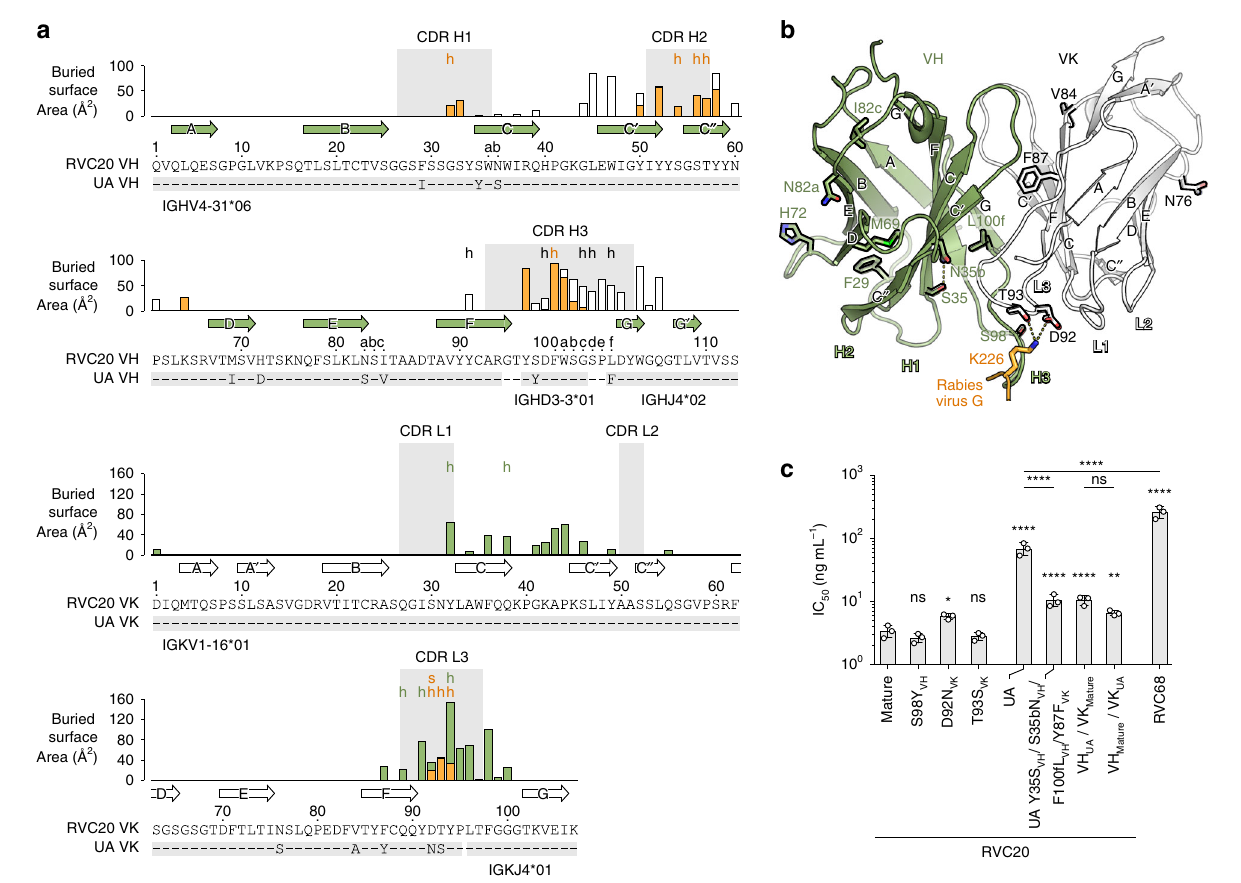
Fig. 2 RVC20 sequence analysis. a Annotation of the RVC20 variable heavy (VH) and variable kappa light (VK) sequences using the Kabat numbering 32 . Differences to the most closely matching germline sequences as determined by IGMT/V-QUEST 27 are indicated below each sequence, de fi ning the inferred unmutated ancestor (UA) sequences. Arrows denote β strands. The color-coded bar chart indicates the BSA per residue in contacts with the light chain, the heavy chain, or the antigen in white, green or orange, respectively; h, hydrogen bond involved; s, salt bridge involved. The CDRs (IMGT convention) are highlighted in gray background. b Positions of the inferred SHMs on the structure of the RVC20 scFv. RABV G residue K226 interacting with D92 VK and T93 VK is shown in orange. c Neutralization of RABV with RVC20 variants or with poorly neutralizing RVC68 on BSR cells 48 h after infection; n = 3 independent experiments. Data are displayed as means ± s.d. Statistical analysis was performed using Tukey ’ s test with α = 0.05. **** P < 0.0001; *** P < 0.001; ** P < 0.01; * P < 0.05; ns, not signi fi cant ( P > 0.05). Source data are provided as a Source Data fi le. Methods expression was then induced with 500 µM CuSO 4 . Cell supernatants were harvested Mammalian cell culture . HEK293-T clone 17 cells (ATCC CRL-11268), BHK-21 1 week after induction, concentrated to 50mL on a 10-kDa MWCO PES membrane (Sartorius), pH-adjusted with 0.1M Tris-Cl pH 8.0, cleared from biotin clone 13 cells (ATCC CCL-10) and BSR cells (a BHK-21 clone, kindly provided by with 15µgmL − 1 avidin, cleared from precipitate by centrifugation at 4000× g for Monique Lafon, Institut Pasteur, Paris) were cultured at 37°C, 5% CO 2 , in Dul- 15 min at 8 °C, and were then used for af fi nity puri fi cation on a 5-mL Strep-Tactin becco ’ s minimal essential medium (DMEM) supplemented with 10% fetal calf Super fl ow hc column (iba Life Science). The two proteins were further puri fi ed by serum (FCS). The BSR-T7 cells 19 (kindly provided by Karl-Klaus Conzelmann, gel permeation chromatography on a HiLoad Superdex 200 pg column (GE Max von Pettenkofer Institute and Gene Center, Munich) for reverse genetics were Healthcare) in 20 mM Tris-Cl pH 8.0, 150mM NaCl, and were subsequently mixed cultured in Glasgow medium supplemented with 10% FCS, 2% (0.59 gL − 1 ) tryp- at equal molar ratio. The complex was puri fi ed by gel permeation chromatography. tose phosphate, 1% non-essential amino acids and 0.1% (50 µgmL − 1 ) geneticin. The fi nal sample was concentrated to a protein concentration of 18 mgmL − 1 in a Recombinant protein preparation for crystallization . Domain III of RABV G (strain 9147FRA, GenBank: AF401286) and the RVC20 scFv were produced in Drosophila S2 cells (Gibco) expressing codon-optimized synthetic genes (Invitro- Crystallization of the RABV G domain III with the RVC20 scFv . Optimal gen) with C-terminal Strep tags (sequence: GGWSHPQFEK) downstream of a BiP crystals were obtained by the sitting-drop vapor diffusion method. A total of 0.7 µL secretion signal (sequence: MKLCILLAVVAFVGLSLG) within the pMT expres- sion vector (Invitrogen). Domain III was constructed joining codons for E31-V56 and N182-D262 with a short linker of three glycine codons. The RVC20 scFv was 22% w/v PEG4000. The drops were equilibrated against reservoir solution for constructed joining the VH and VK coding regions with a glycine-serine linker of 2 weeks at 18°C. Crystals were then cryo-protected in 80 mM Tris-Cl pH 8.0, 20 codons (sequence: GGGGS GGGGS GGGGS GGGGG). All cloning primers are listed in Supplementary Table 1. S2 cells were grown at 28°C in HyClone SFM4Insect medium with L -glutamine (GE Healthcare) supplemented with 25UmL − 1 penicillin/streptomycin (Gibco). Crystallographic data collection and structure determination . X-ray diffraction Expression plasmids were co-transfected with the selection plasmid pCoPURO 20 at a mass ratio of 20:1 using Effectene transfection reagent (Qiagen) according to the data were recorded on synchrotron beamline PX2 at SOLEIL in St Aubin, France, manufacturer ’ s instructions. Polyclonal stable S2 cell lines were established by with an EIGER X 9M detector (Table 1). The wavelength was set to 0.9801 Å. Data selection with 7.5µgmL − 1 puromycin (Invivogen), which was added to the were processed using XDS 21 and the STARANISO web server (Global Phasing medium 40 h after transfection. Cultures were expanded to 1L of 10 7 cells mL − 1 in Ltd.). Initial phases were obtained by molecular replacement in Phenix.MR 22 using Erlenmeyer fl asks shaking at 100 rpm and at 28°C. Recombinant protein a model of the RVC20 scFv generated with the Phyre2 web server for 3D homology NATURE COMMUNICATIONS| (2020) 11:596